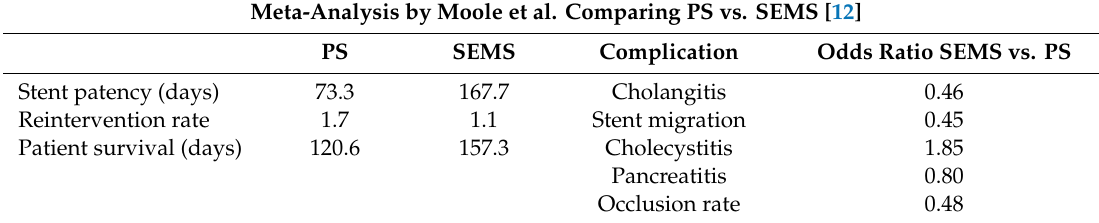
Table 1. Statistical comparison of Plastic stents (PS) vs. Self-expandable metallic stents (SEMS). Meta-Analysis by Moole et al. Comparing PS vs. SEMS [12] PS SEMS Complication Odds Ratio SEMS vs. PS